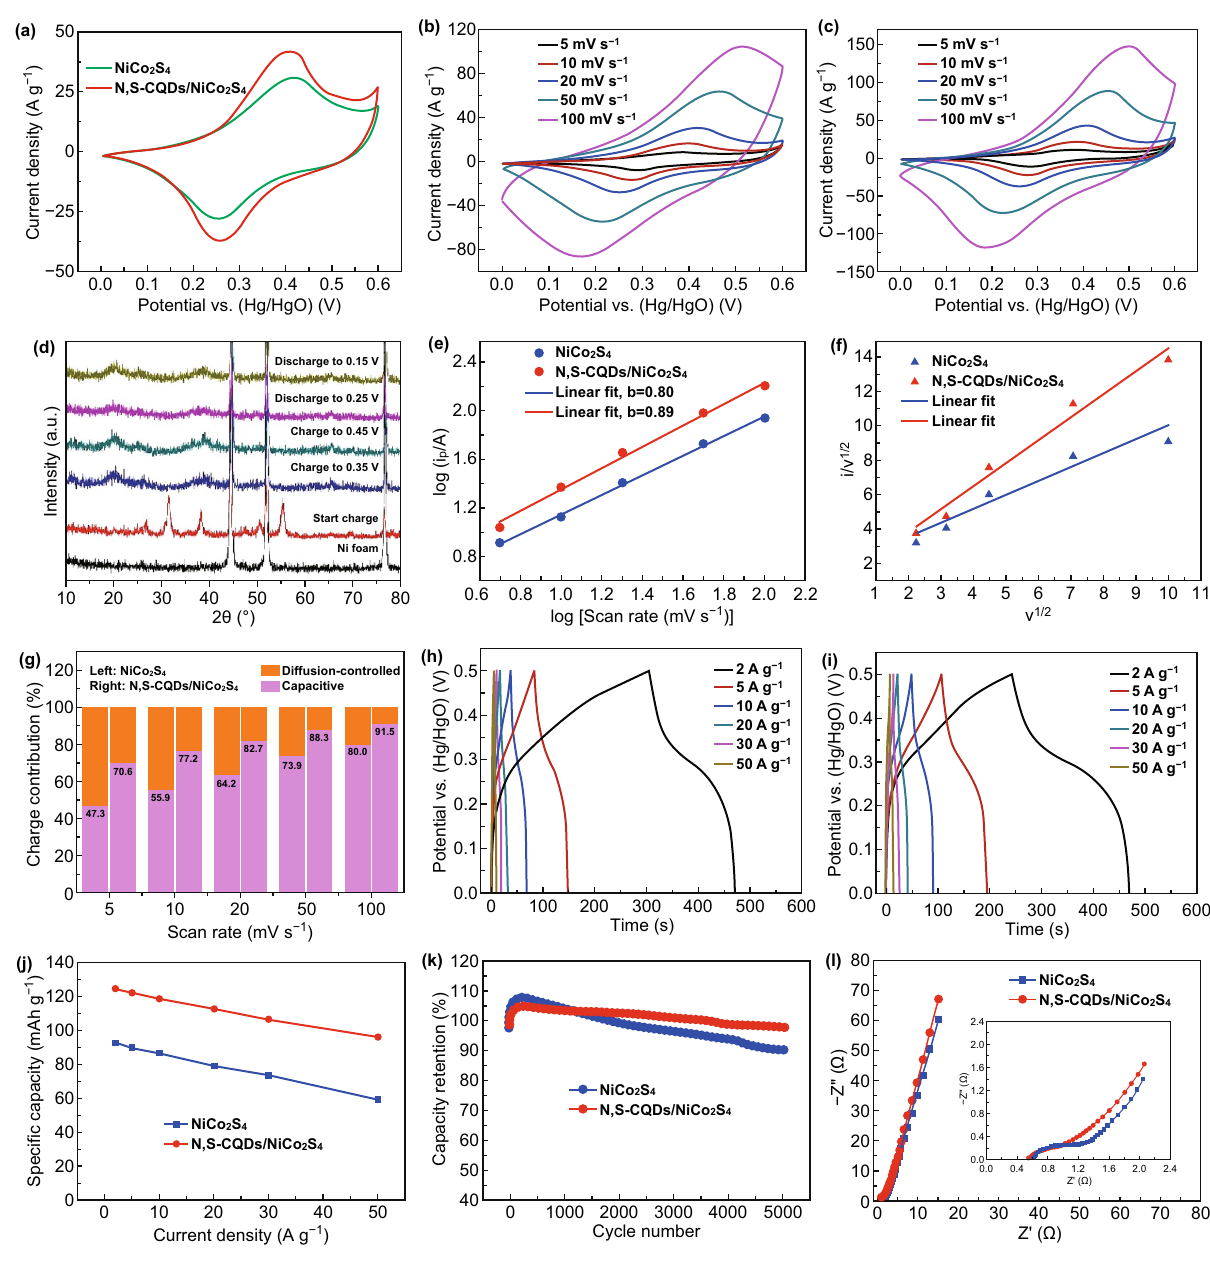
Fig. 5 a Comparison of CV curves of the pristine NiCo 2 S 4 and N,S‑CQDs/NiCo 2 S 4 electrodes at 20 mV s −1 . CV curves at various scan rates of the b pristine NiCo 2 S 4 and c N,S‑CQDs/NiCo 2 S 4 electrodes. d Ex‑situ XRD measurement of the N,S‑CQDs/NiCo 2 S 4 electrode during different electrochemical steps. e The fitting lines of log (scan rate, mV s −1 )‑log (i p , A), f i/ν 1/2 –ν 1/2 , and g the charge contribution of the pristine NiCo 2 S 4 and N,S‑CQDs/NiCo 2 S 4 electrodes. GCD curves at various current densities of the h pristine NiCo 2 S 4 and i N,S‑CQDs/NiCo 2 S 4 electrodes. j The rate performances, k cycling performances, and l EIS plots of the pristine NiCo 2 S 4 and N,S‑CQDs/NiCo 2 S 4